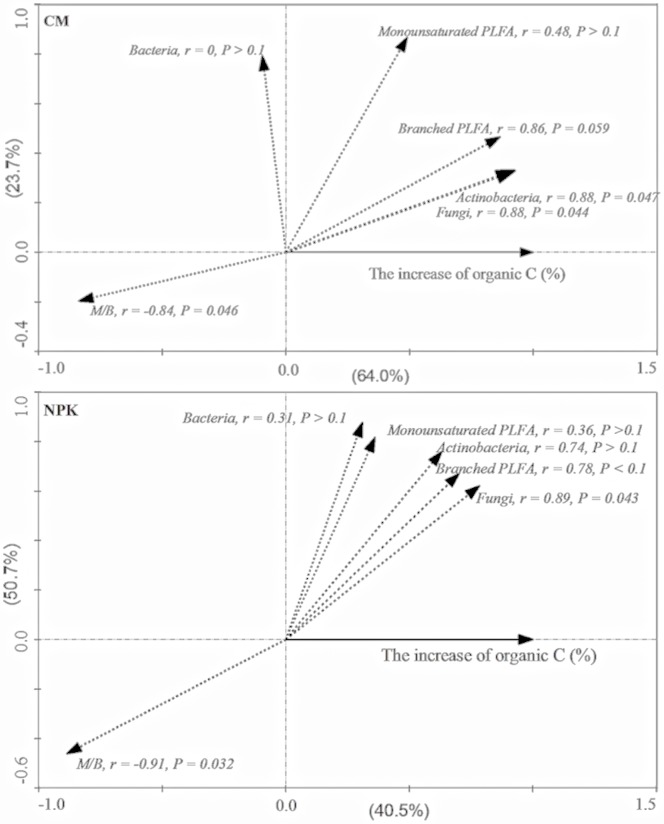
Relationship between increased organic C and the abundance of microbial PLFA (nmol g–1 aggregate) in soils.Redundancy analysis (RDA) and regression analyses were used to test relationships between the increased organic C concentration in the CM and NPK treatments compared with the control and the abundance of microorganisms in aggregates in the CM and NPK treatments.